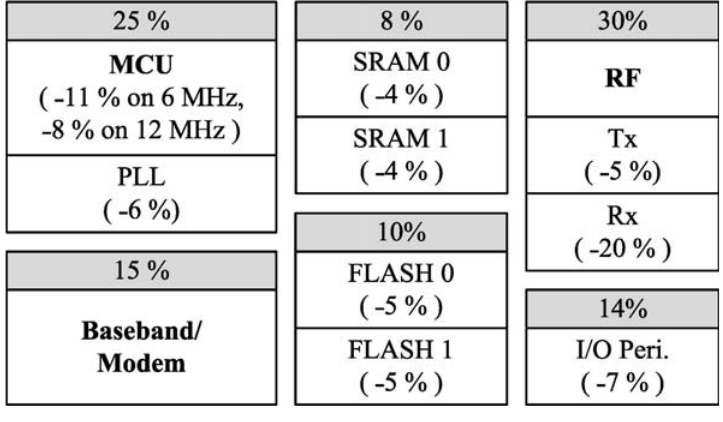
Figure 9. Power consumption and saving ratios of power-controllable hardware